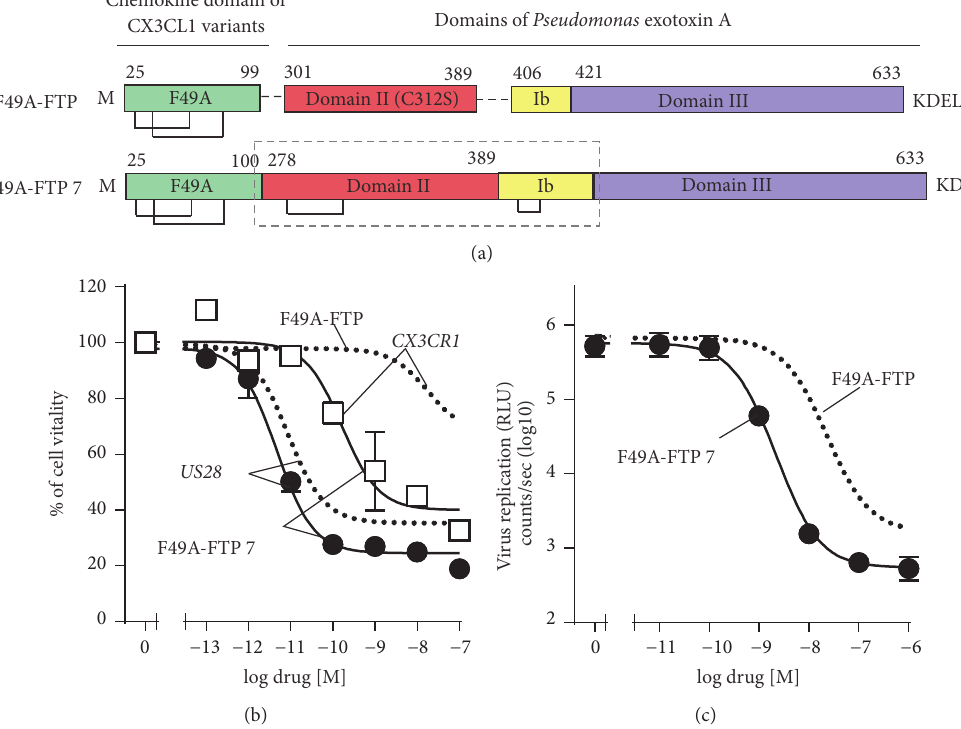
Figure 5: Design, cell killing, and antiviral activity of an FTP with full domains of PE. (a) F49A-FTP-7 with full catalytic active domains of PE. (b) F49A-FTP-7 induced cell killing in comparison to F49A-FTP (dotted line) on tetracycline induced HEK-293 cells expressing US28 (black circles) and CX 3 CR1 (white squares). (c) Inhibition of virus replication measured by luciferase activity of MRC-5 cells infected with Toledo LUC (MOI 0,1) and treated once with F49A-FTP (dotted line) or FTPs from this group (black circles). Error bars indicate SEM for 2–5 independent biological